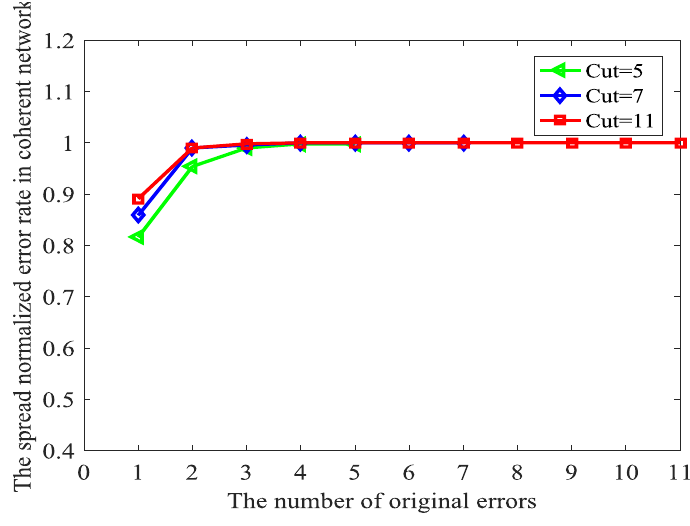
Figure 7. The spread of errors in the coherent networks.